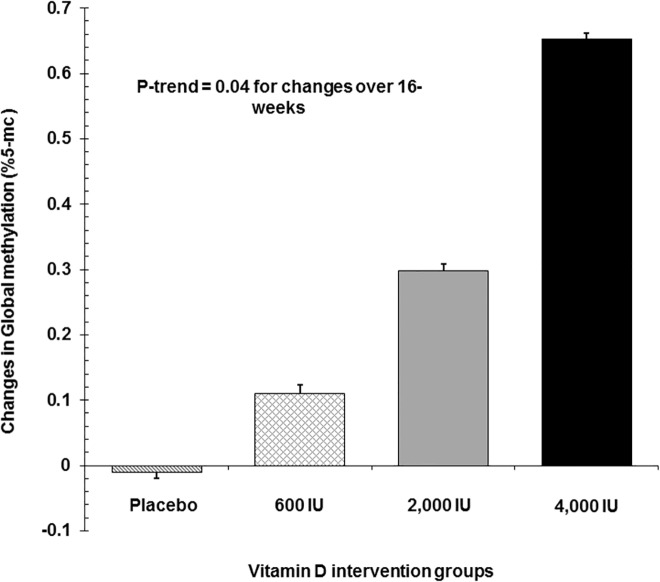
Changes in global methylation in response to 16 week vitamin D3 supplementation (placebo, 600 IU/d, 2,000 IU/d, or 4,000 IU/d).Data represent mean ± SE. p trend <0.01.